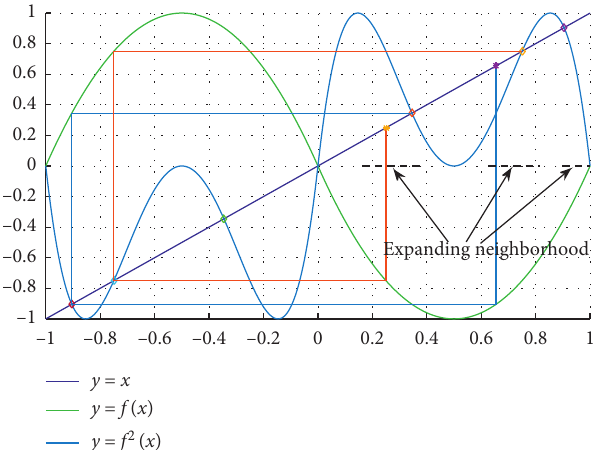
Figure 1: Heteroclinic cycles connecting expanding periodic